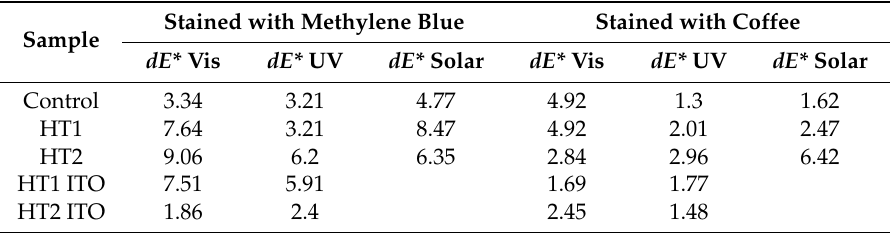
Table 4. Color differences ( dE* ) of the polyester fabrics treated with TiO 2 -1% Fe–N photocatalysts, stained with 0.01 g/L methylene blue (MB) or coffee, and exposed to visible, ultraviolet (UV) and solar